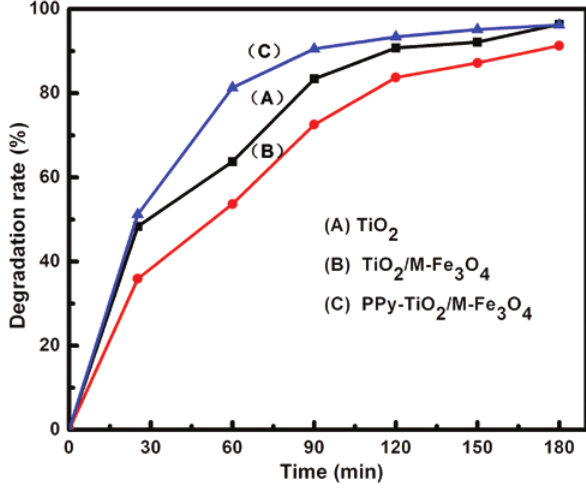
Figure 5 Methyl orange degradation rate-time curves under ultraviolet light.